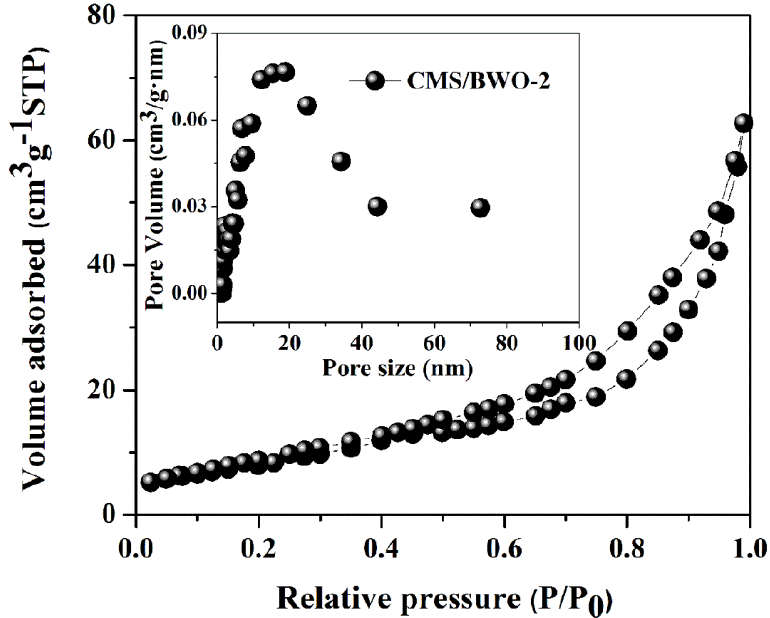
Figure 3. N 2 adsorption–desorption isotherms and the pore size distribution curves (inset) of CMS/BWO-2.